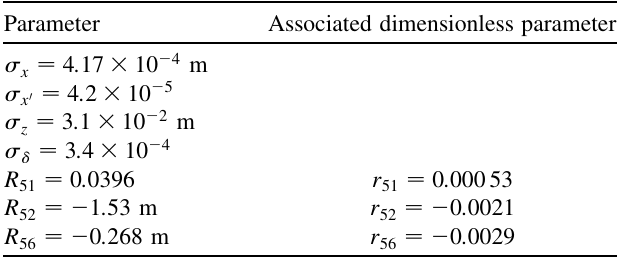
TABLE II. Beam and dipole parameters used in the numerical calculations. Parameter Associated dimensionless parameter